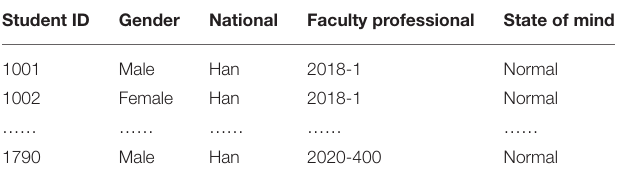
TABLE 2 | Students’ basic